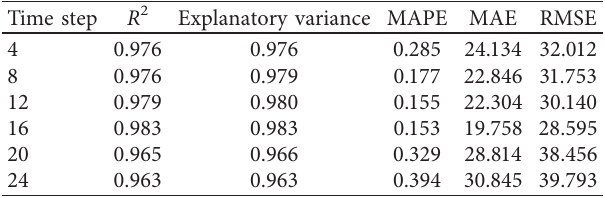
Figure 13: 24 steps LSTM training and prediction. (a) 24 steps LSTM loss function and (b) 24 steps LSTM prediction results. Table 5: Comparison of short-term traffic flow prediction effect in different time steps.